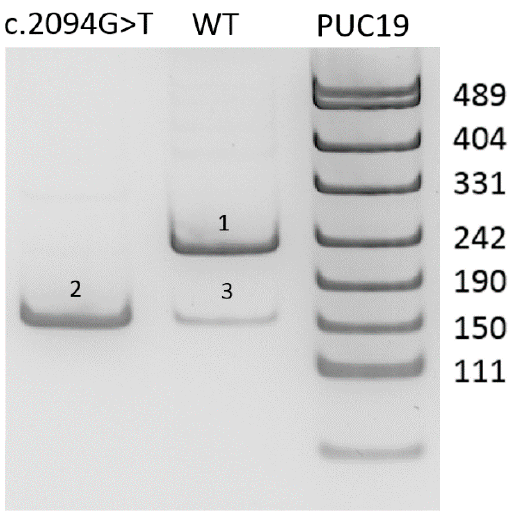
Figure 1. Results of minigene assay. Visualisation of PCR products from amplification of minigene- specific cDNA. 1—Wild type (WT) transcript isoform. 2—transcript isoform with PREPL exon 14